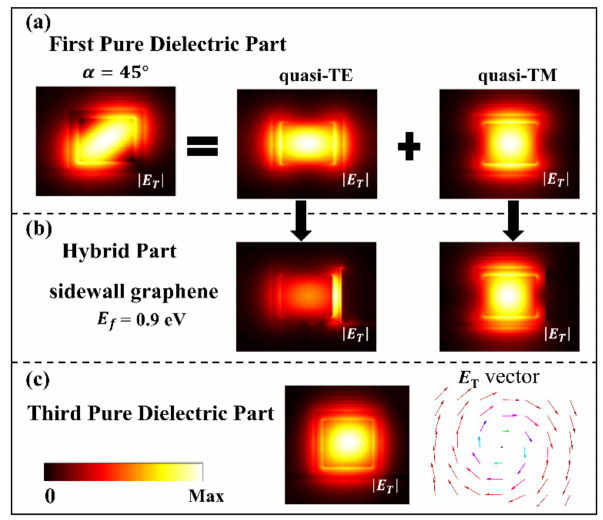
Figure 3. ( a ) Transverse component of the electric field ( | E T | ) of a linearly polarized light with α = 45 ◦